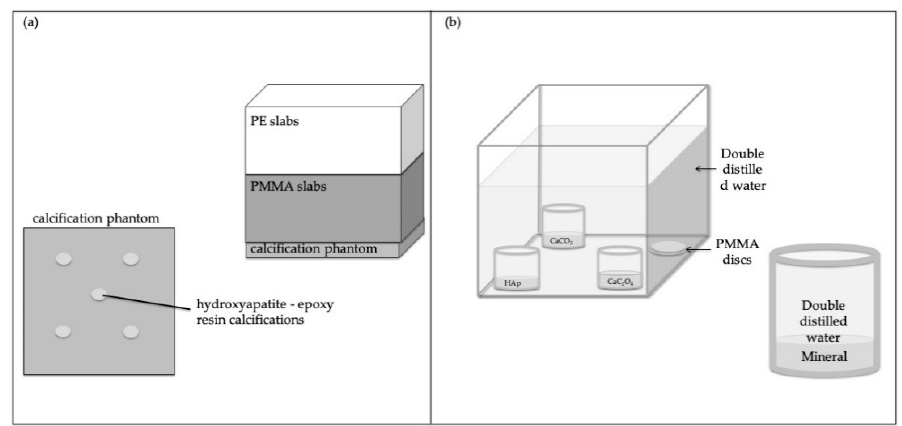
Figure 3. Schematic representation of the used phantoms in the experimental studies [26,28]; ( a , b ) calcification for dual energy mammography technique.